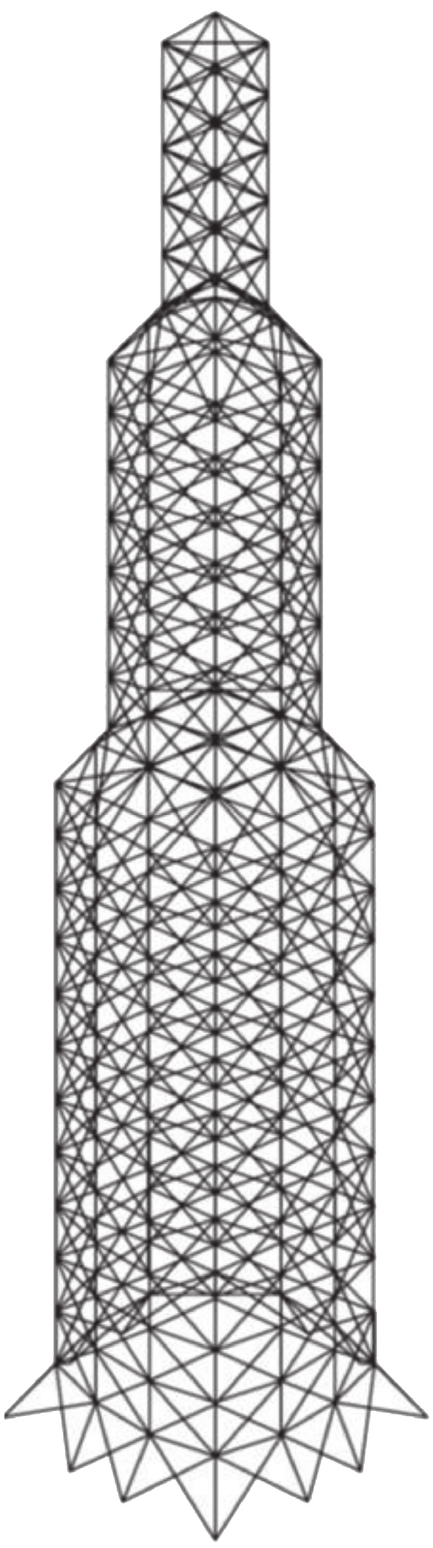
Figure 14: Layout of the 942-bar truss (reproduced from Hasancebi [47], under the Creative Commons Attribution License/public